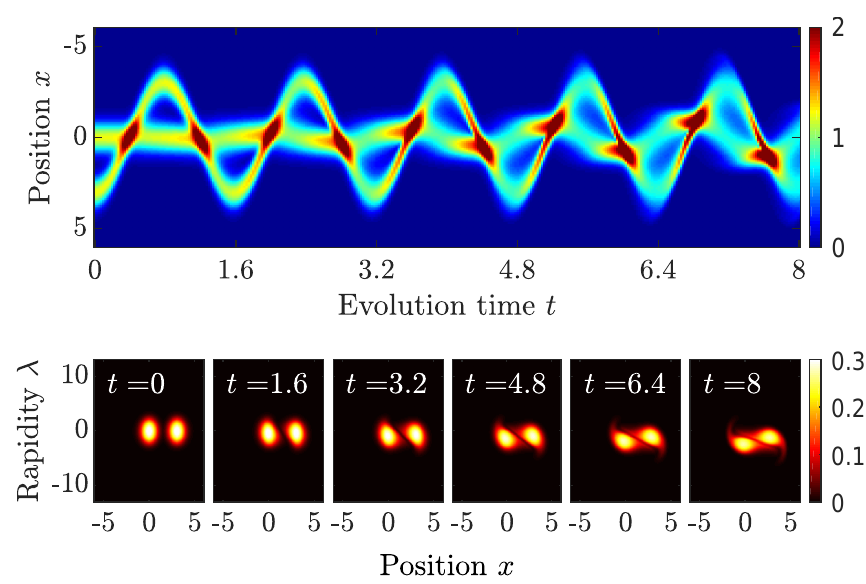
Figure 1: Above: Evolution of the linear density of a Bose gas in a Newton’s cradle. The interactions between the oscillating and stationary cloud transfers momentum between them. At the end of the evolution, the system moves as a single cloud exhibiting both a center-of-mass and breathing motion. Below: Snapshots of the root density at each period. Initially the two clouds have distinct root densities, which gradually merges into a single, binary